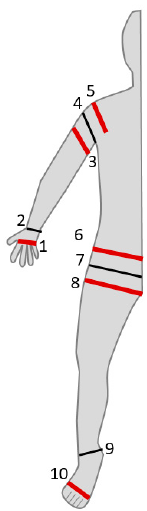
Figure 3. Electrode placements for segmental measurements.